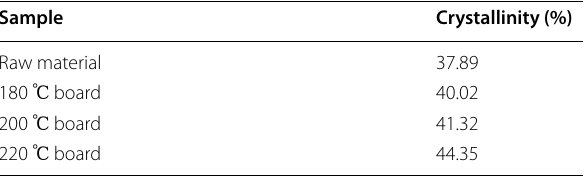
Table 5 Crystallinity change of cellulose from different samples